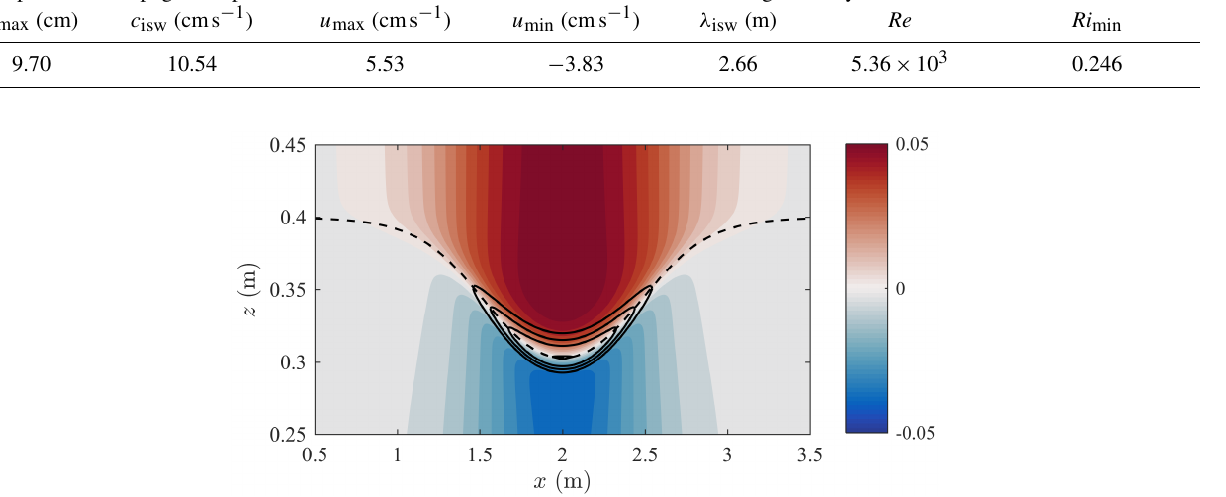
Figure 3. Filled contours showing the horizontal velocity induced by the ISW, with positive current shown in red and negative current shown in blue. The dashed curve shows the isopycnal displacement along the pycnocline. The black contours show the gradient Richardson number with Ri = 0 . 25, 0.4, 0.6, and 1 from inside to